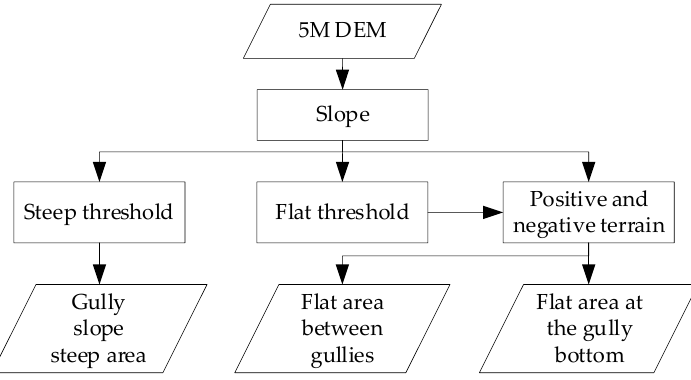
Figure 5. The study area division extraction flowchart.